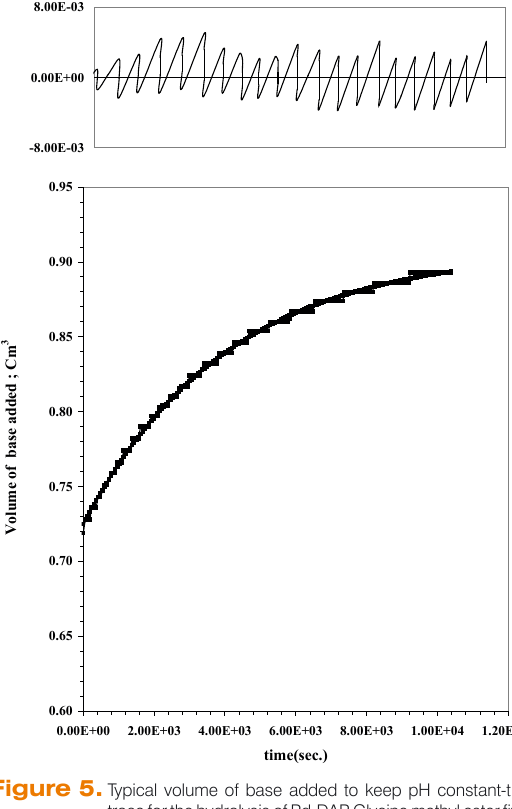
Figure 5. Typical volume of base added to keep pH constant-time trace for the hydrolysis of Pd-DAP-Glycine methyl ester fitted with one exponential function. The top of the figure shows the volume of base difference between the measured and calculated kinetic traces at I = 0.1 M; pH = 4.4; T=25 o C.